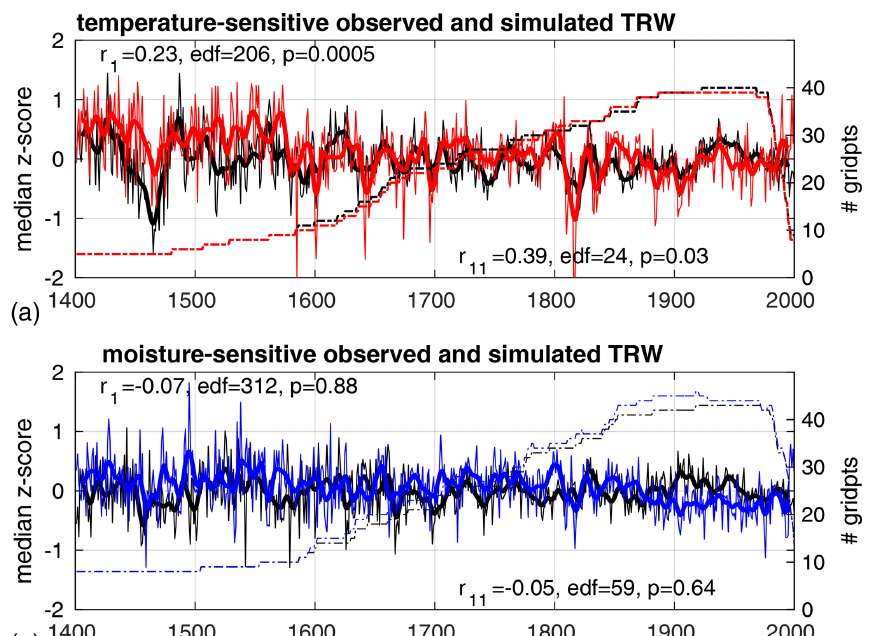
Figure 5. (a) Mean series for observed (black) and all-forcing-simulated temperature-sensitive chronologies (red). Annually resolved and a 11-year Hanning window filtered time series are shown with thin and bold lines, respectively. Labels quantify the Pearson correlation ( r ), effective degrees of freedom (edf, Hu et al., 2017) and the p value. The x axis is in units of years CE. (b) The same as (a) above but for moisture-sensitive observations (black) and simulations (blue). Note that this plot shows the global means of standardized TRW at all grid boxes with data before high-pass filtering and variance adjustment. There are small differences in numbers of observed and simulated chronologies that arise from both the observational masking and from the simulation parameter validation procedure (Sect.